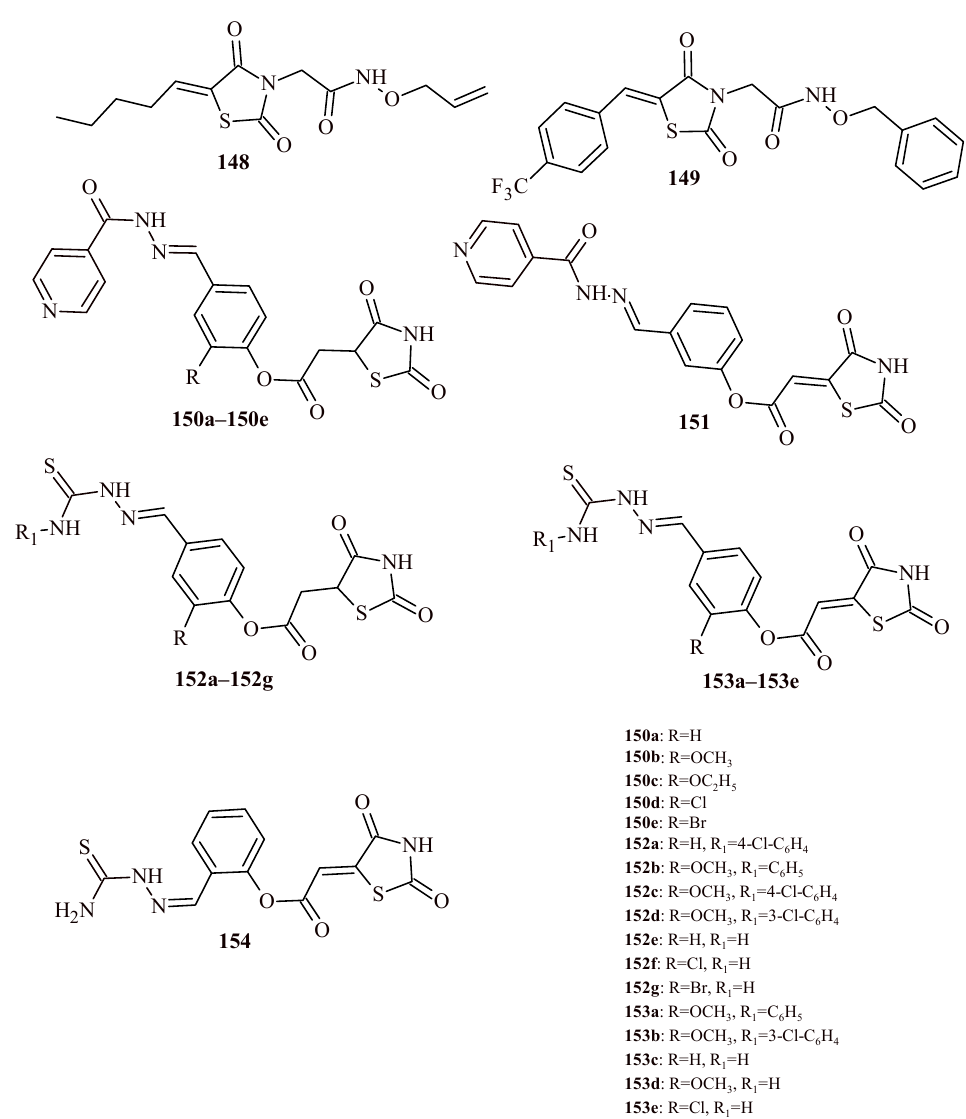
Figure 56. Thiazolidine-2,4-dione derivatives with antitubercular